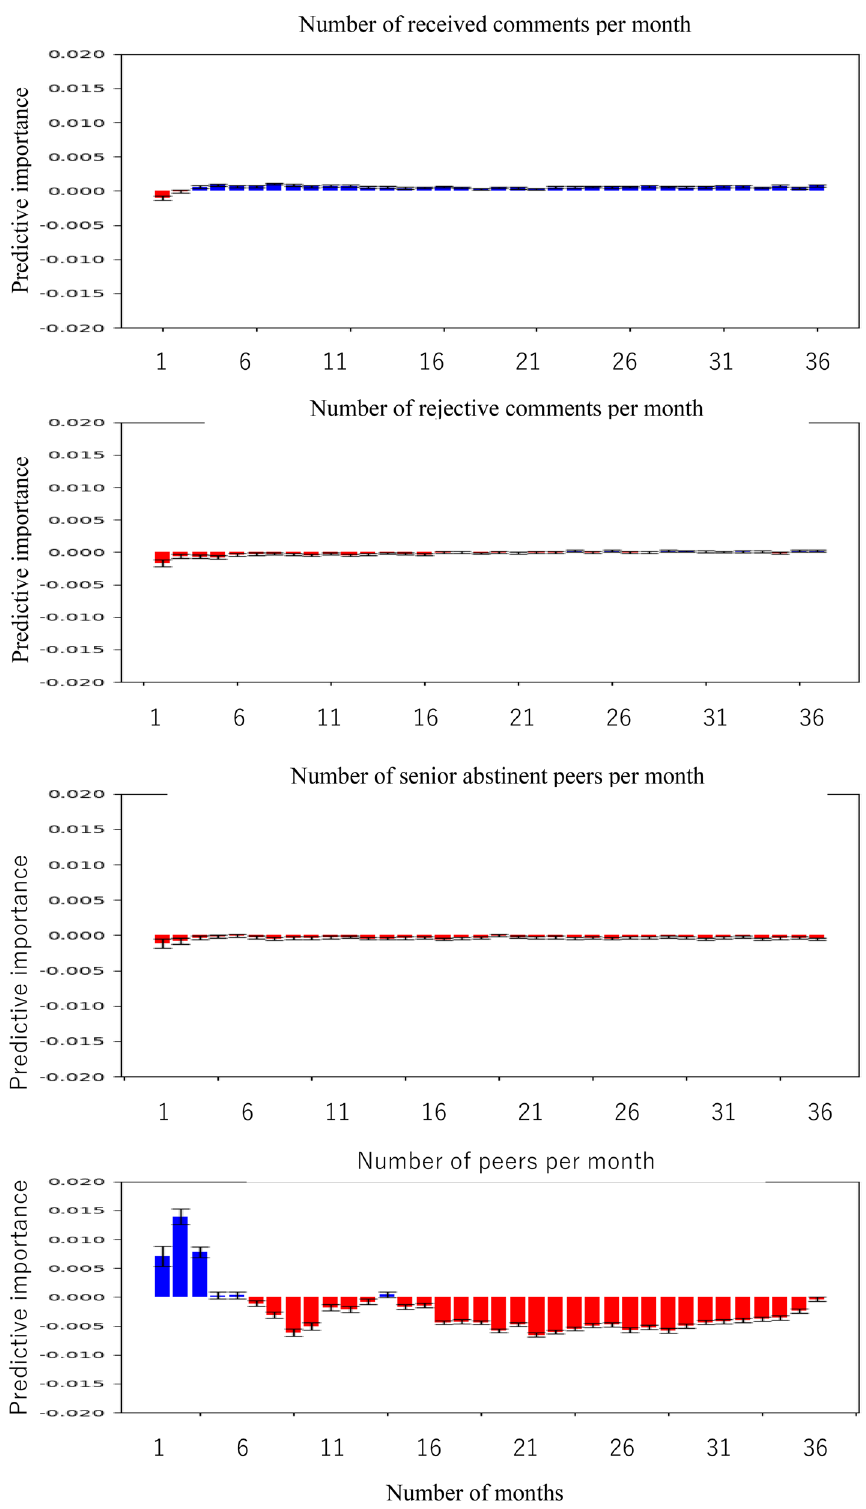
Figure 3. Comparison of predictive importance for abstinent gamblers among received comments, rejective comments, senior abstinent peers, and peers for 36 months. Notes: Blue and red bars indicate the positive and negative values of predictive importance in the local interpretable model-agnostic explanations (LIME). Positive values of predictive importance in a feature indicate that it positively predicts abstinent gamblers, whereas negative values in another feature indicate that it negatively predicts abstinent gamblers. The classifier used was the K-nearest neighbor algorithm (KNN), and the AUC of the KNN was